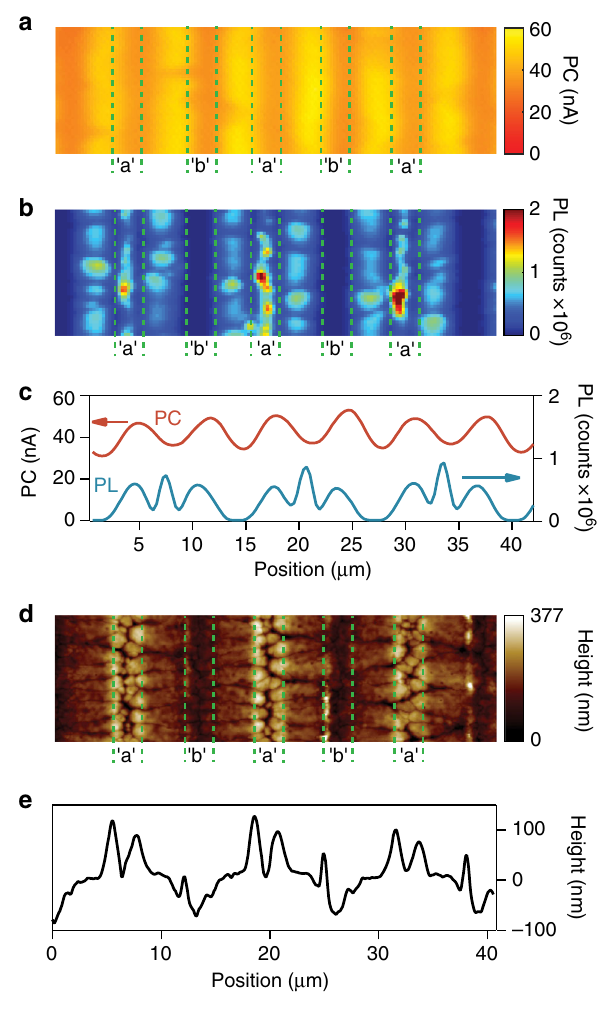
Fig. 4 Spatial photocurrent and photoluminescence mapping of self- assembled monolayer modi fi ed back-contact perovskite solar cells. a Spatial PC map of a SAM-modi fi ed bc-PSC at short-circuit condition. b Spatial PL map of a SAM-modi fi ed bc-PSC at short-circuit condition. c PC and PL pro fi le obtained by averaging the PC and PL maps along the vertical direction. d Atomic-force-microscopy (AFM) topography map of a SAM-modi fi ed bc-PSC. e AFM topography map pro fi le of a SAM-modi fi ed bc-PSC. The scanned area in all subpanels is 42 × 12